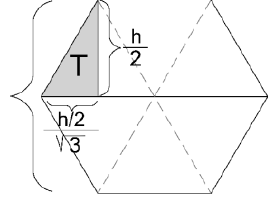
Figure 2. Hexagonal cell weight and height